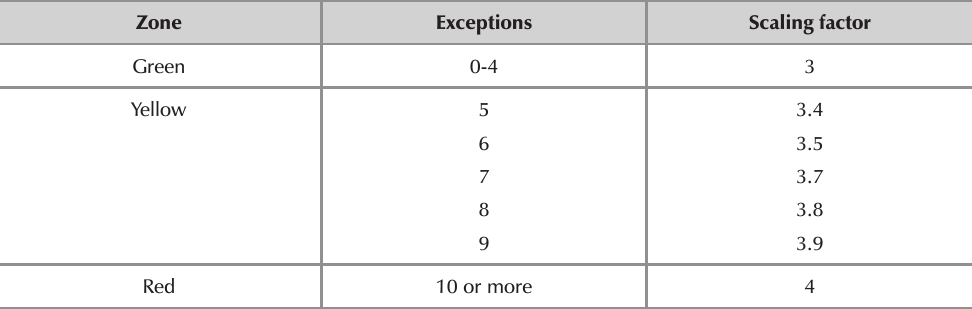
Number of exceptions with corresponding scaling